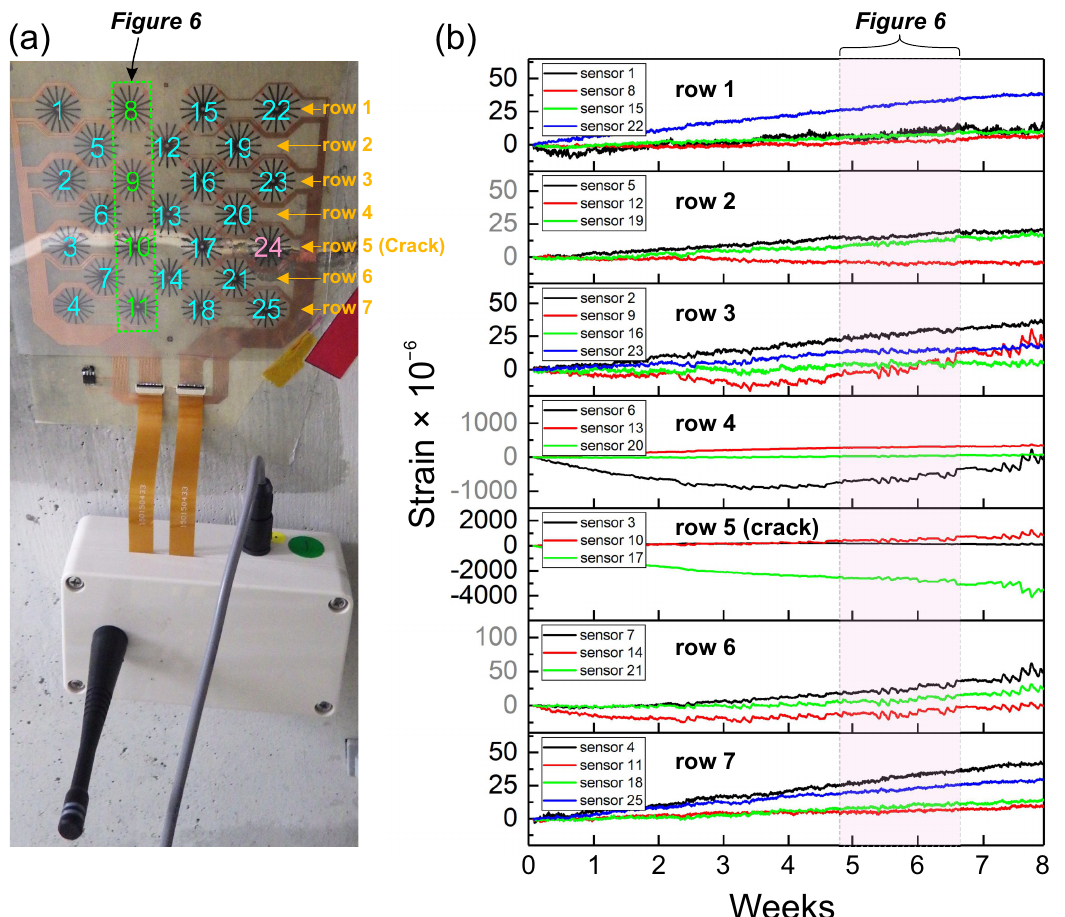
Figure 5. ( a ) Sensor array installed on the crack. The brightness and contrast of the photographs were changed locally to show the position of the crack. ( b ) Results of a two-month-long static strain analysis using a sensor array installed on the